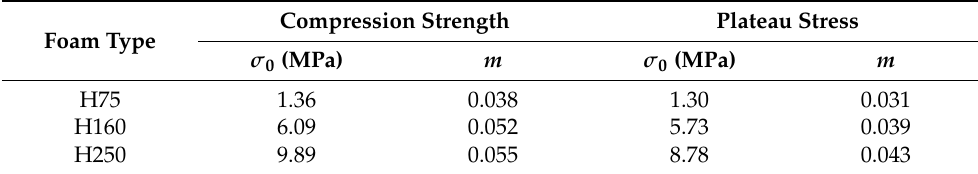
Table 2. Power law exponent for various PVC